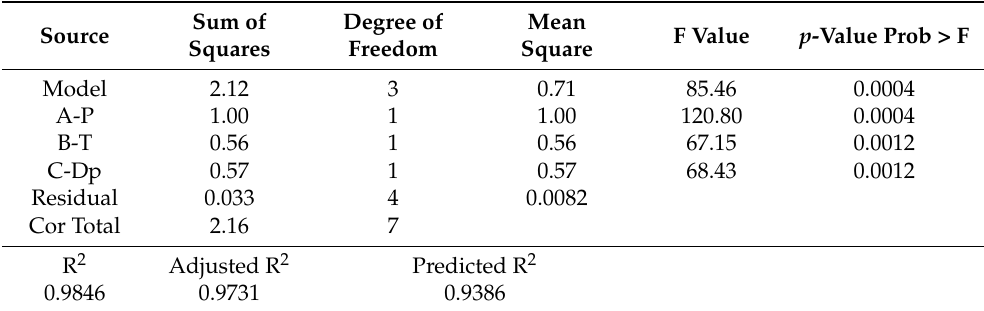
Table 2. Analysis of variance (ANOVA) for the model fitted to the SC-CO 2 extraction process of rosemary essential